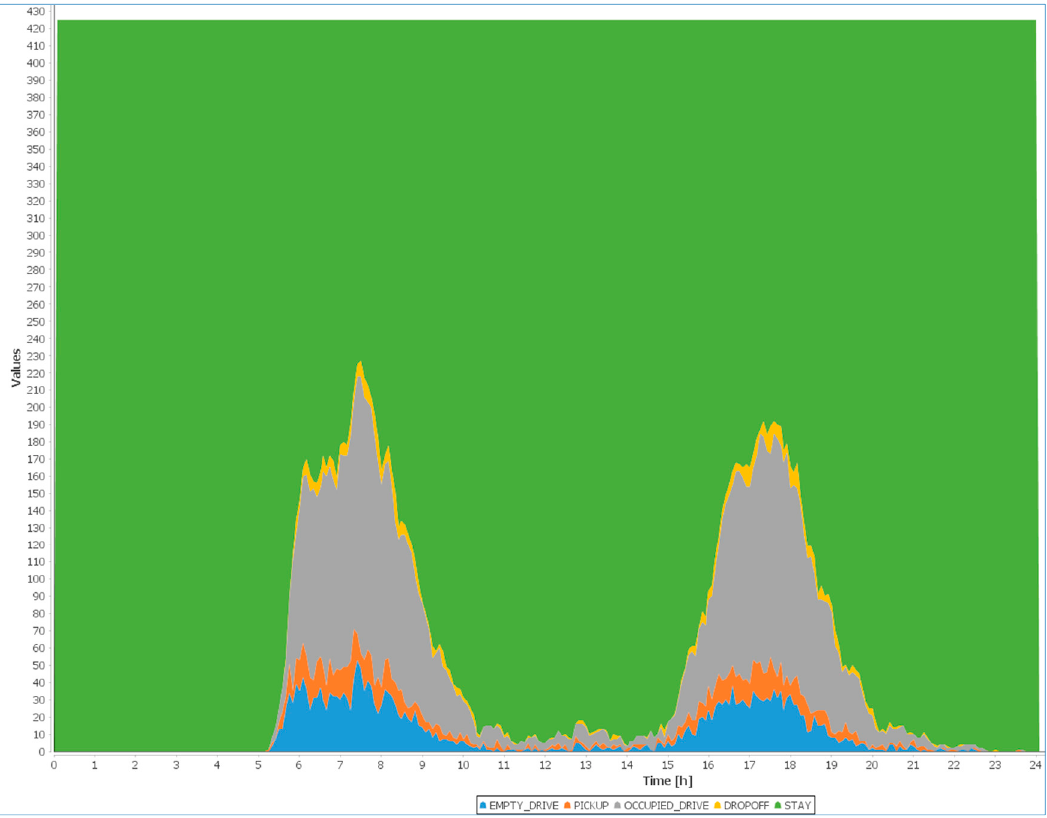
Figure 4. Time profile of the AV fleet, when the AV fleet size and the utility of travelers were optimized.